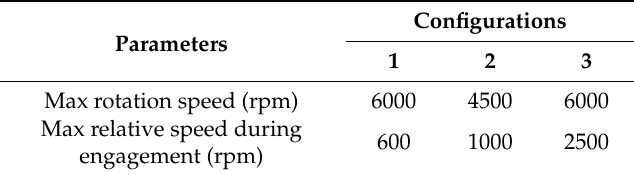
Table 2. The three configurations for the design archetype (DA) layout.